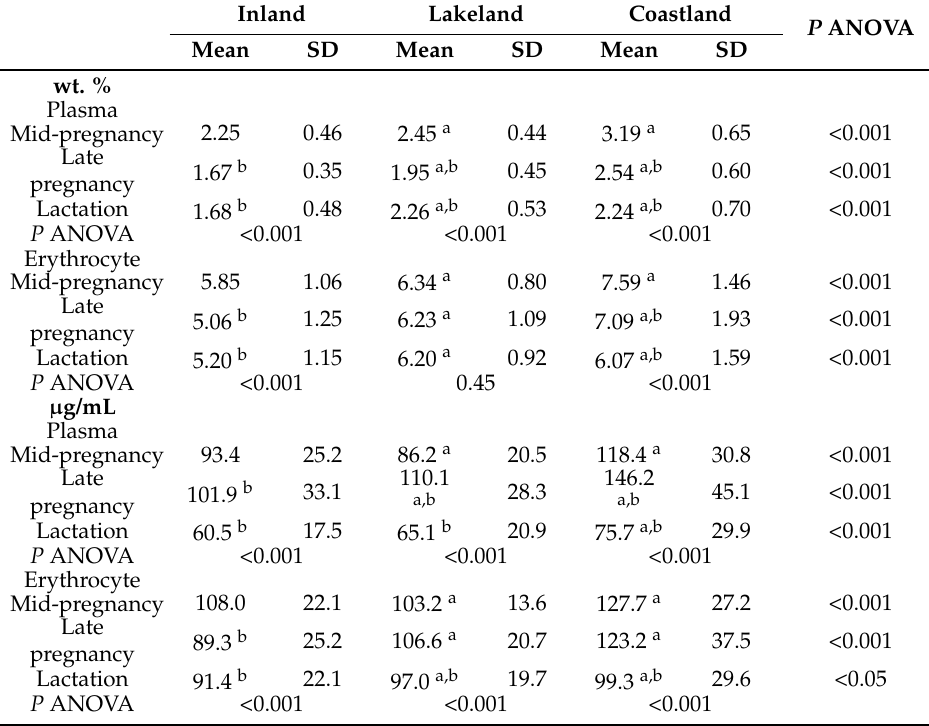
Table 2. Docosahexaenoic acid (DHA) concentrations by region and participant